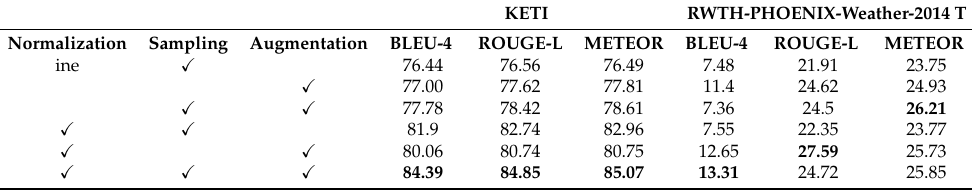
Table 10. Ablation Study of Video-Processing Methods. “Normalization” means our customized nor- malization method. “Sampling” is our skip sampling method and “Augmentation” is our stochastic augmentation